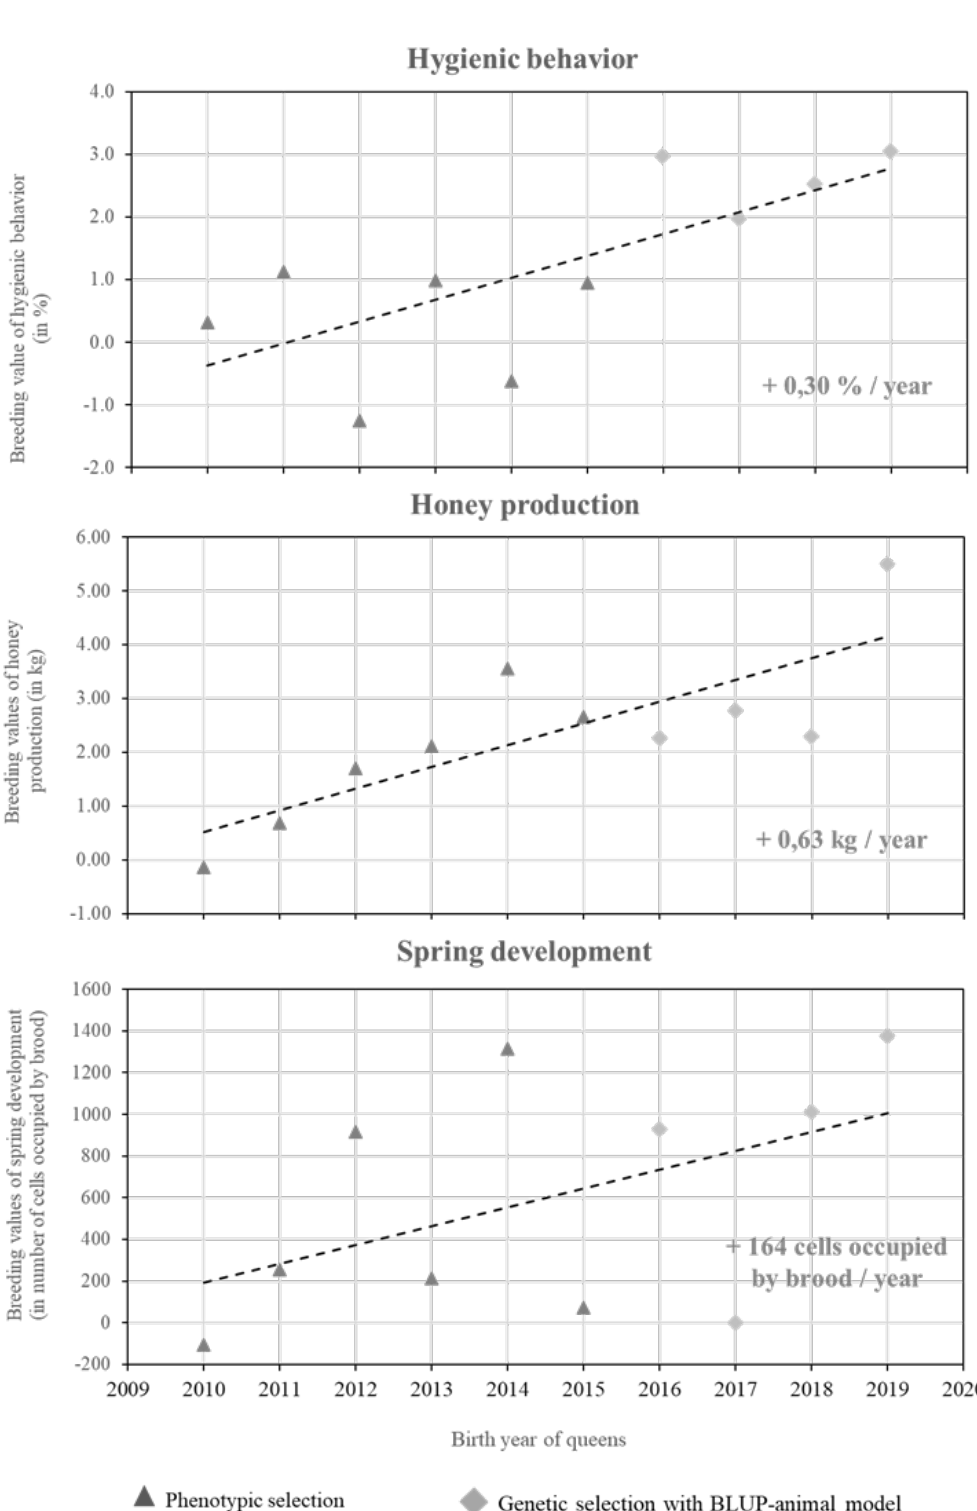
Figure 4. Genetic improvement for three traits: hygienic behavior, honey production and spring development in the UL-CRSAD honeybee breeding program since 2010. Each point represents average breeding value of all colonies by year. The dark grey triangles represent the average breeding value per year before introduction of the BLUP-animal methodology and the light grey diamonds represent the average breeding value per year following its introduction. The average annual improvement for each trait (regression coefficients) is shown in each graph at the bottom right.